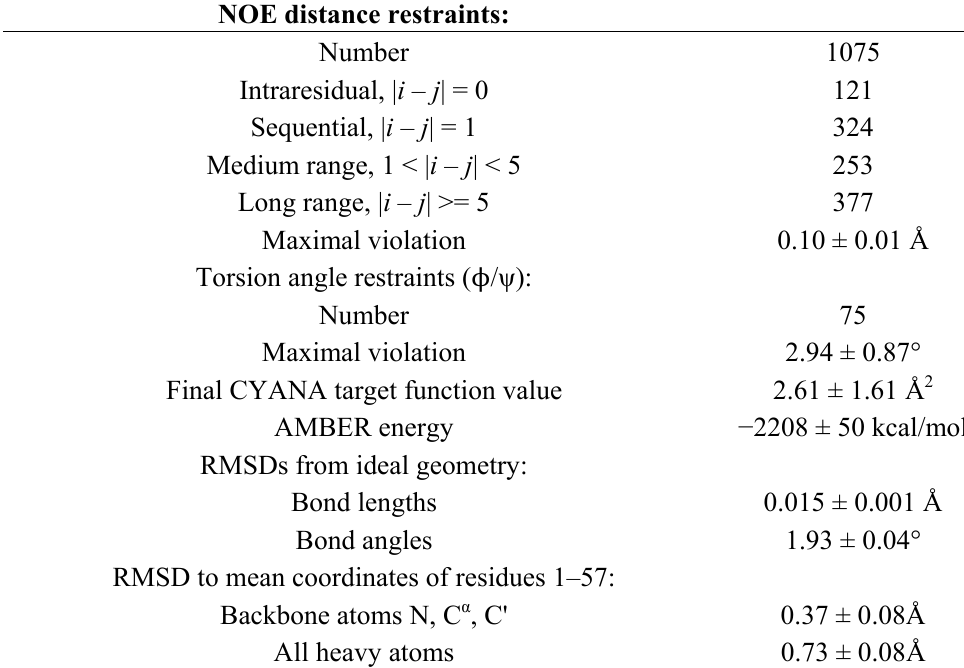
Table 1. Structural statistics for the NMR solution structure of